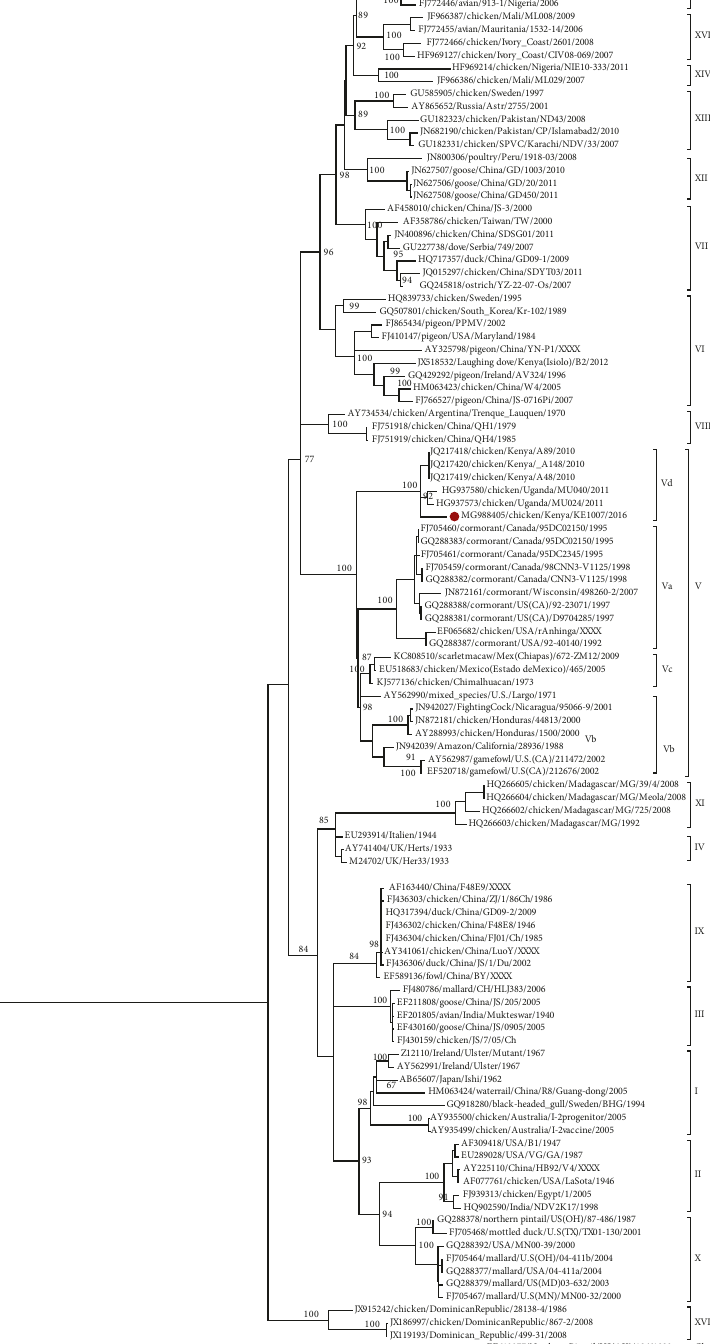
Figure 3: Phylogenetic tree of nucleotide sequence of the complete fusion (F) gene of Newcastle disease virus (NDV) obtained in this study (marked ) and reference sequences from GenBank. The percentage of replicate trees in which the associated taxa clustered together in the bootstrap test (1000 replicates) is shown next to the branches (only > 50% is shown). The evolutionary history was inferred by using the maximum likelihood method based on the Tamura Nei model [31]. The gamma correction for rate heterogeneity was 0.4141. The analysis involved 109 nucleotide sequences. The tree is rooted using the NDV sequence belonging to Class I. There were a total of 1662 positions in the final dataset. The analyses were conducted in MEGA